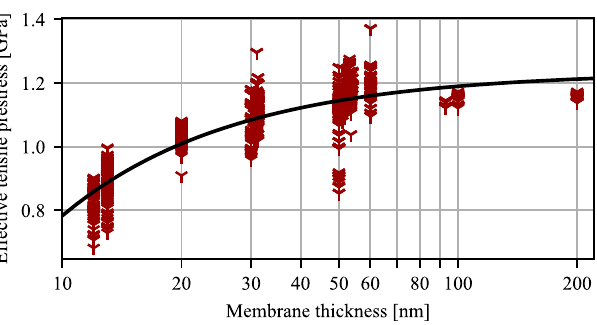
Fig. 7 Stress versus thickness. Extraction of the stress-thickness relation of stoichiometric silicon nitride based on frequency measurements of